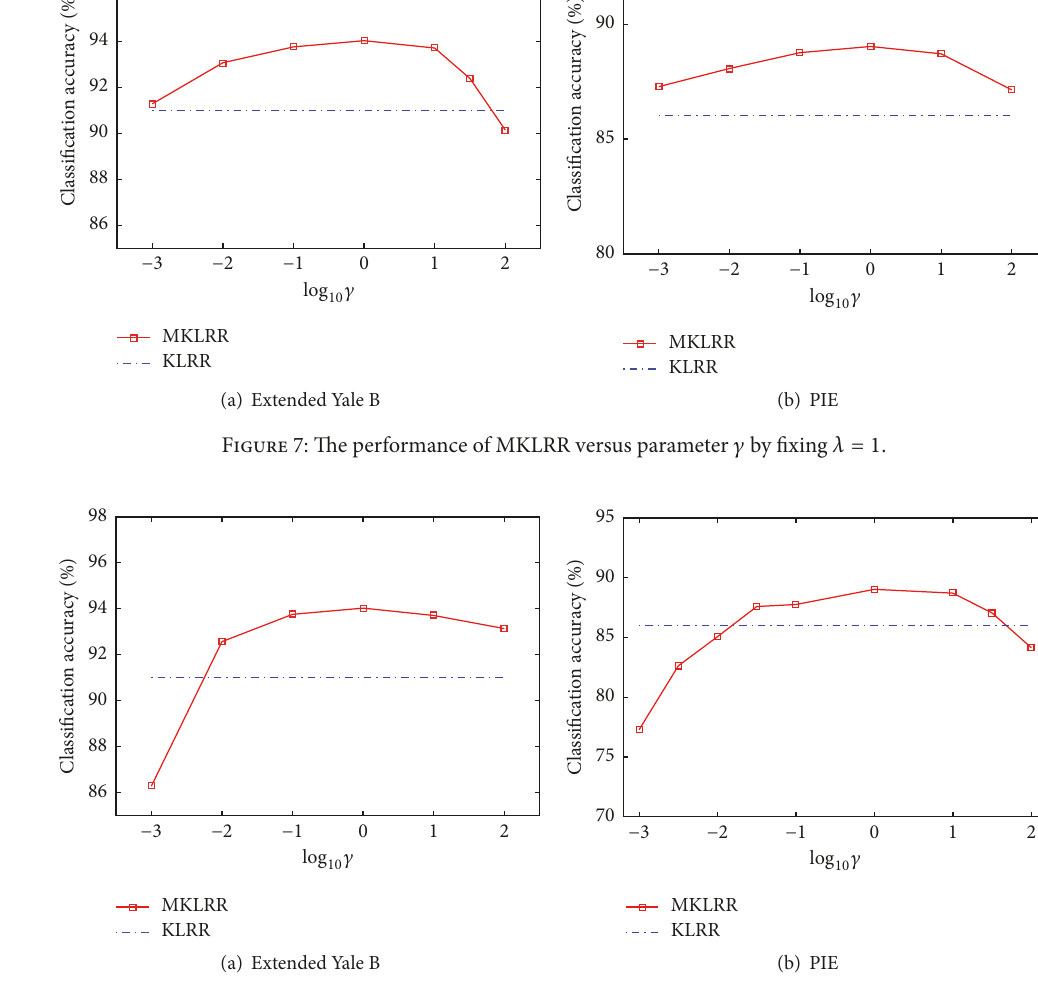
Figure 8: The performance of MKLRR versus parameter 𝜆 by fixing 𝛾 = 1